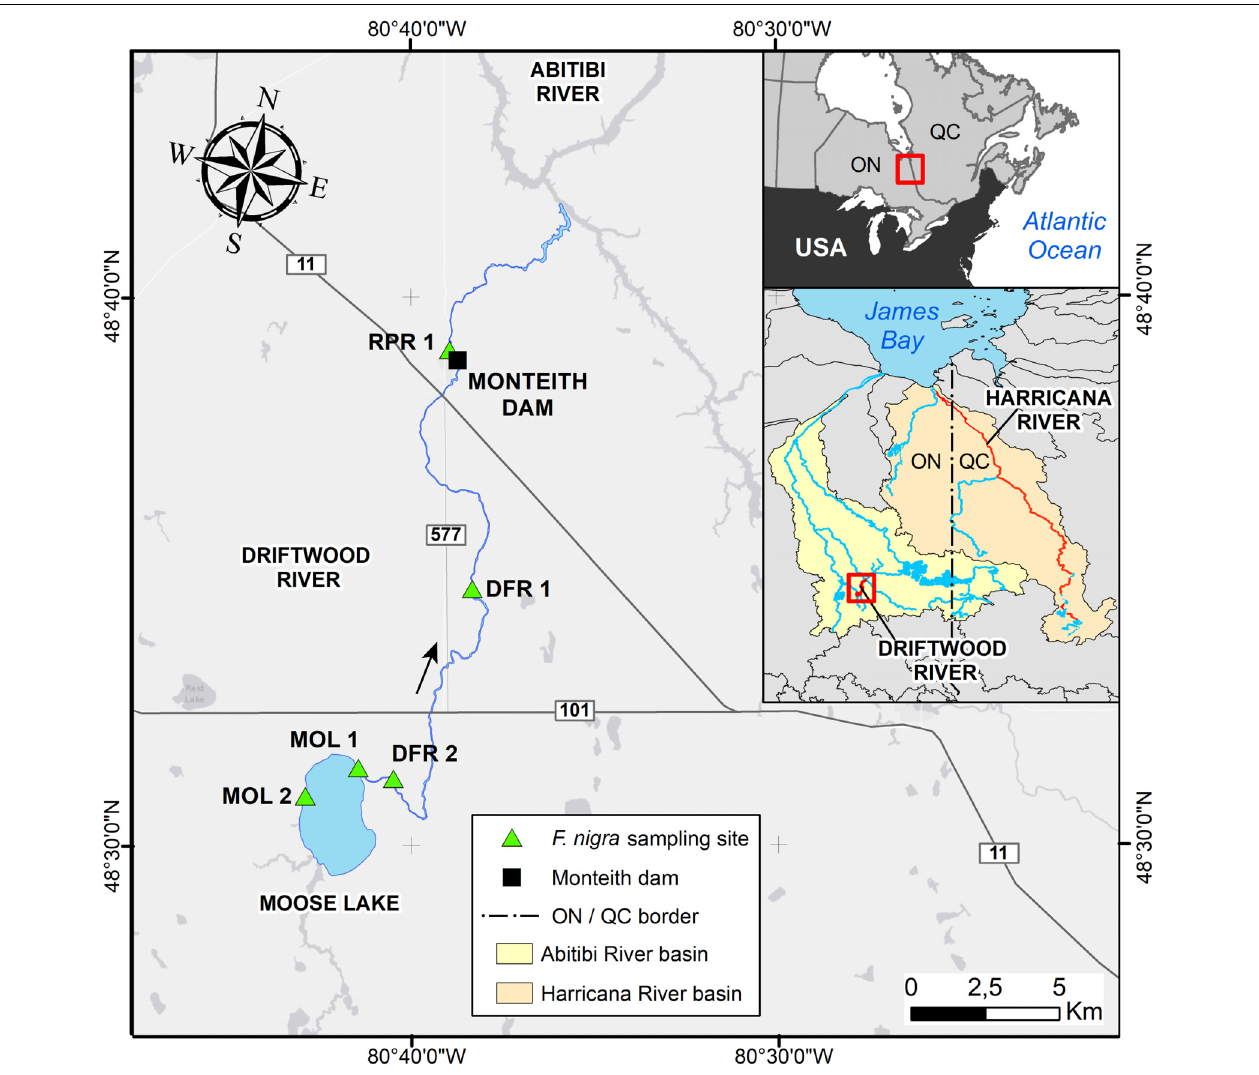
FIGURE 1 | Map of the study area. The geographic location of the Driftwood River at the border between Ontario and Québec in Canada (upper right inset) and within the Abitibi River basin (lower right inset). Locations of the Fraxinus nigra sampling sites along the Driftwood River are coded as follows: MOL - Moose Lake; DFR - Driftwood River; RPR - Rapid